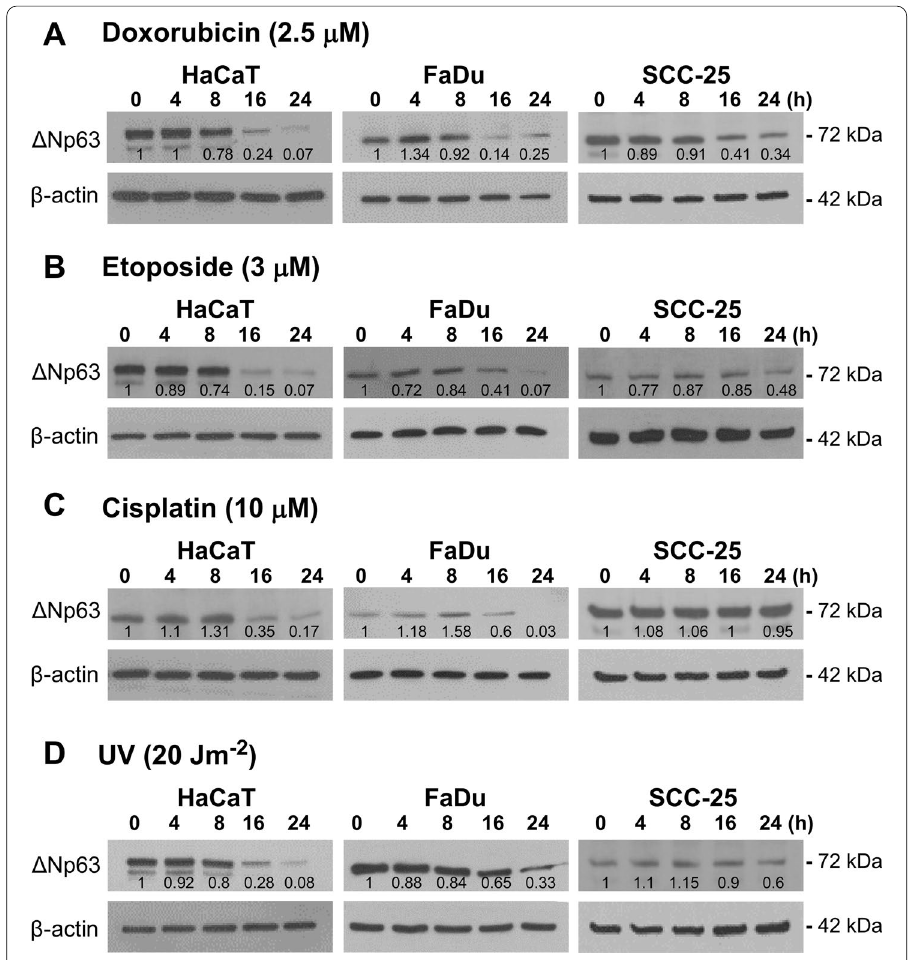
Fig. 2 DNA damaging agents decrease ΔNp63. Representative western blots of ΔNp63 (72 kDa) in HaCaT, FaDu or SCC-25 cells taken at the indicated times after exposure to A doxorubicin, B etoposide, C cisplatin and D UVC light. β-actin (42 kDa) is shown as loading control. Relative ΔNp63 densitometry measurements normalized to β-actin are